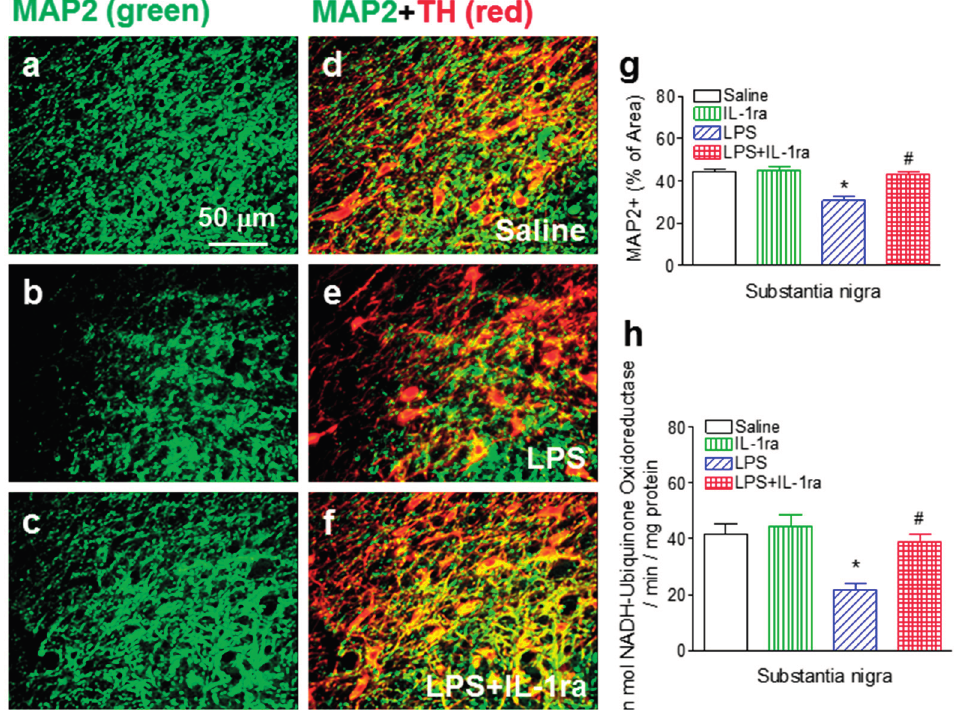
Figure 3. IL-1ra attenuated neonatal LPS-induced dendritic damage and reduction in mitochondrial complex I activity in the SN area of the P70 rat brain. Representative photomicrographs of MAP2+ (green color) ( a – c ); TH+ (red color) cells; or double-labeled cells (yellow) ( d – f ); ( a , d ) saline-treated group; ( b , e ) LPS-treated group; ( c , f ) LPS+IL-1ra group. Scale bar: 40 μ m; ( g ) Quantitation of the percentage area of image that contained MAP2+ staining in the SN of P70 rat; ( h ) Quantitation of the enzymatic activity of mitochondrial complex I in the SN of P70 rat. The results are expressed as the mean ± SEM of six animals in each group, and analyzed by two-way ANOVA. * p < 0.05 represents significant difference for the LPS group as compared with the saline